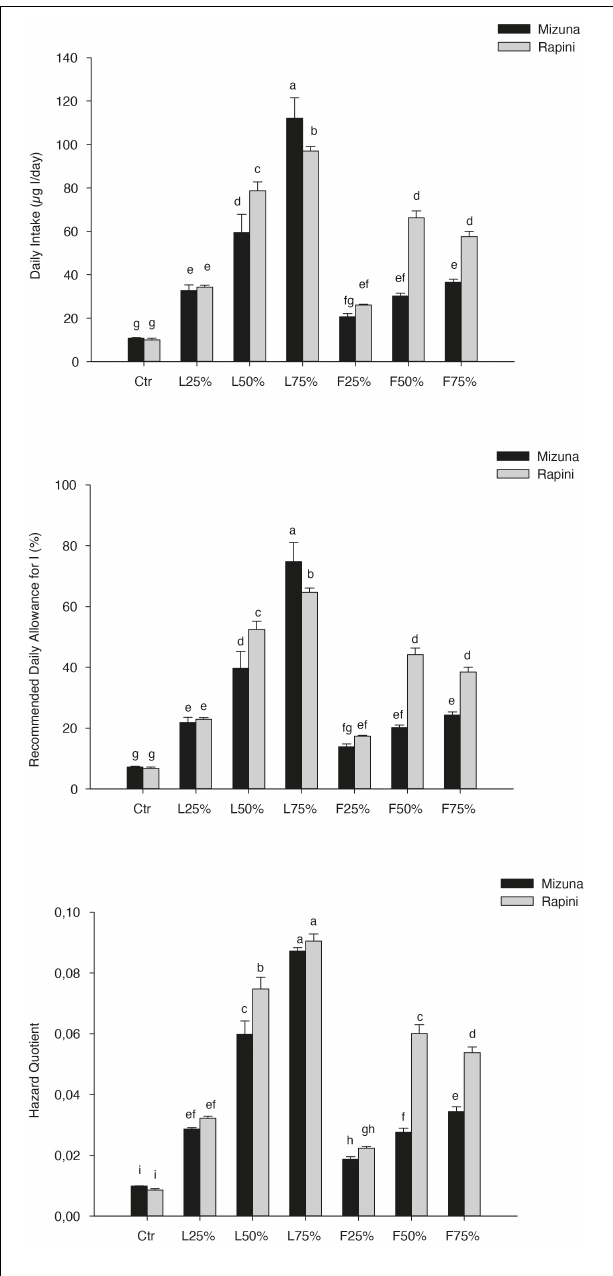
FIGURE 5 | Daily intake, percentage of recommended daily allowance for I (RDA-I) and hazard quotient (HQ) for intake of I through consumption of 100-g portions of Mizuna and Rapini microgreens, produced in greenhouse, by adult humans (70 kg body weight). Significance: *** P ≤ 0.001. Different letters indicate that mean values are significantly different according to the LSD test ( α = 0.05).